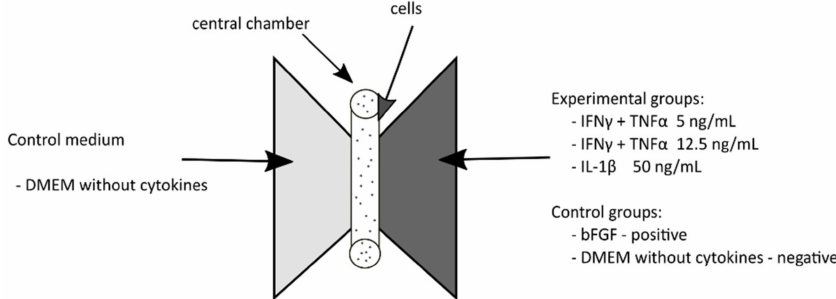
Figure 2. A schematic chemotaxis assay. Left chamber contained basic culture medium (DMEM), right chamber contained medium with tested factors (bFGF—positive control, DMEM without cytokines-negative control or proinflammatory factors) and central chamber with